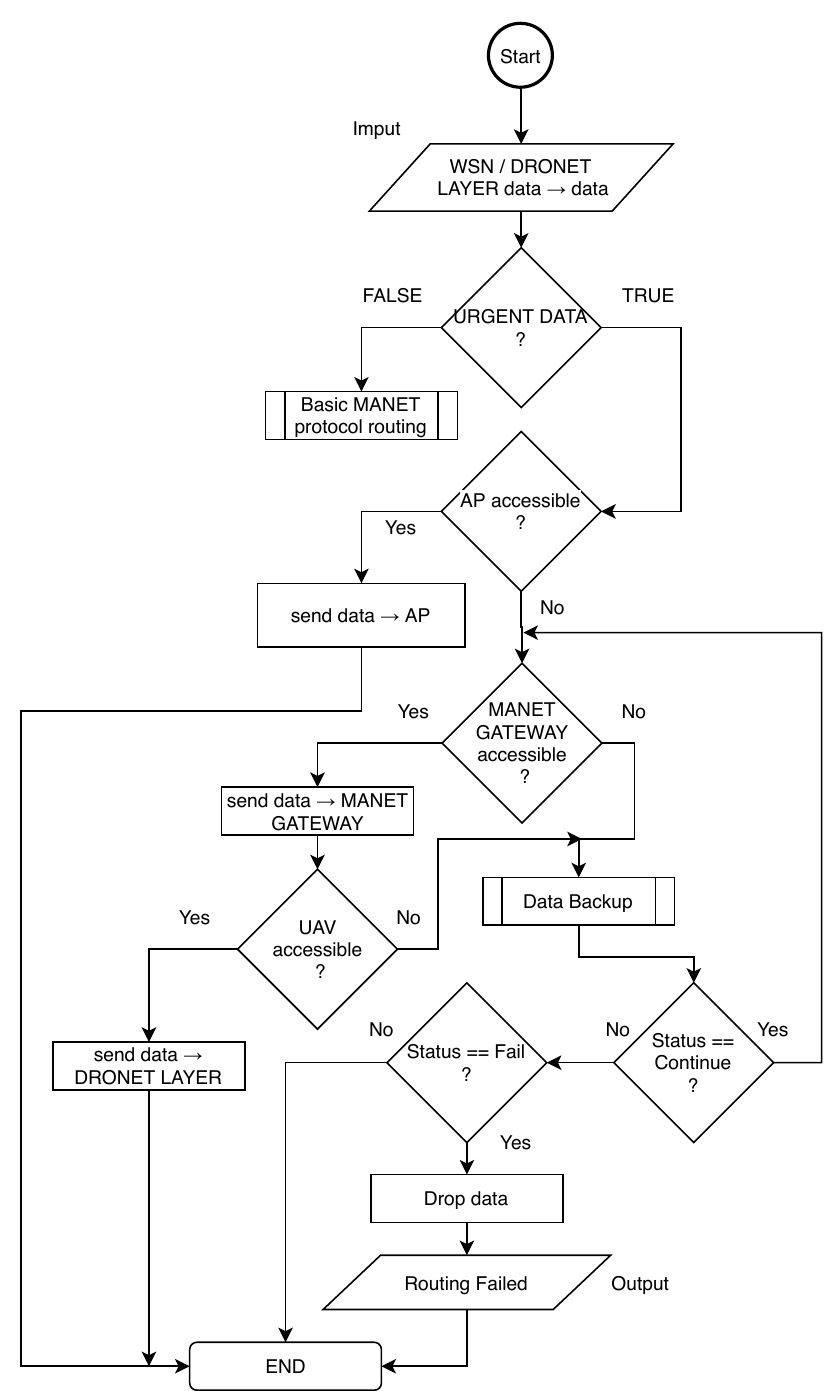
Figure 10. The MANET Layer routing